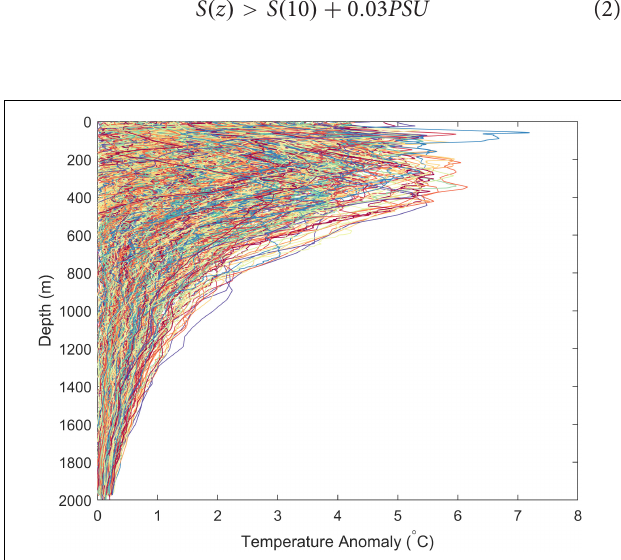
FIGURE 2 | Temperature anomaly profiles in MHWs cut off at their respective Positive Threshold Depths.